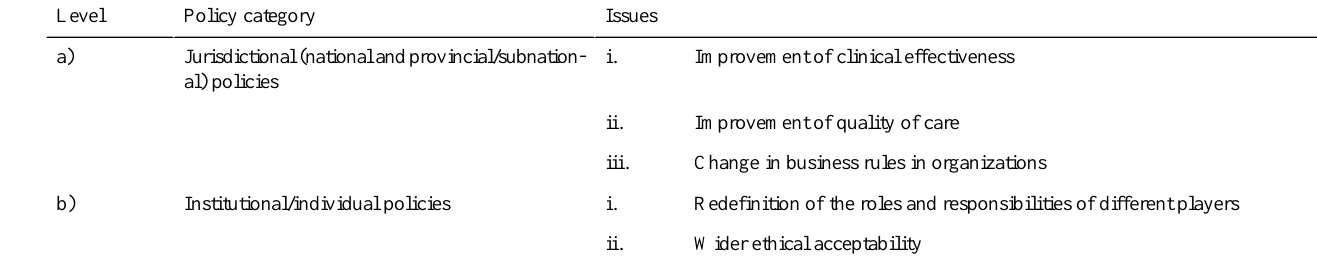
Table 4. eHealth integration with the existing systems.